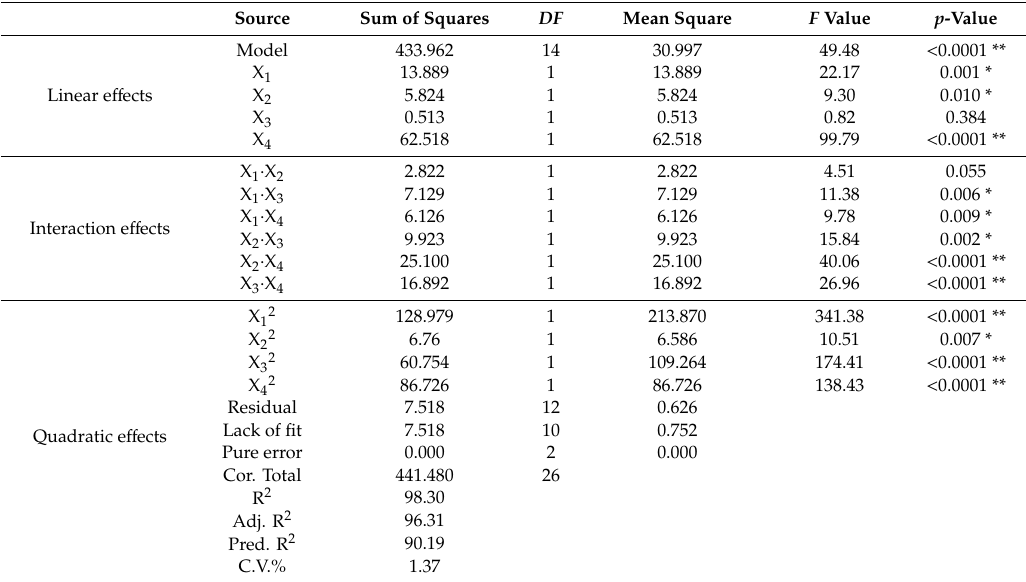
Linear e ff ects